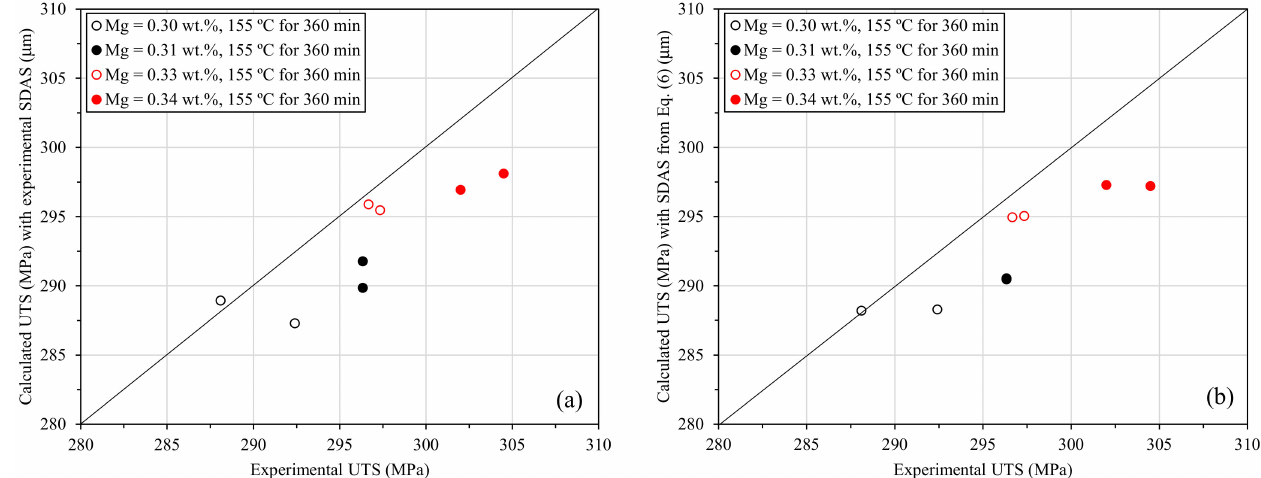
Figure 20. Comparison of experimental UTS values obtained from the SK-8 castings and those predicted by using Equation (28) and data included in Table 11. Two different SDAS parameters are used: experimentally measured SDAS ( a ) and the values of this parameter determined with Equation (6) ( b ). Black symbols correspond to SK-8 castings manufactured with 0.30 wt.% Mg (open circles) and with 0.31 wt.% Mg (solid circles) while red symbols correspond to castings produced with 0.33 wt.% Mg (open circles) and with 0.34 wt.% Mg (solid circles). All SK-8 castings were aged at 155 ◦ C for 360 min. Solid lines are the bisectors.